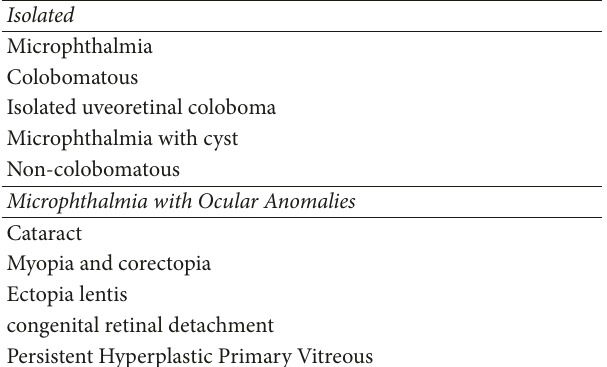
Table 1: A Practical Classification of